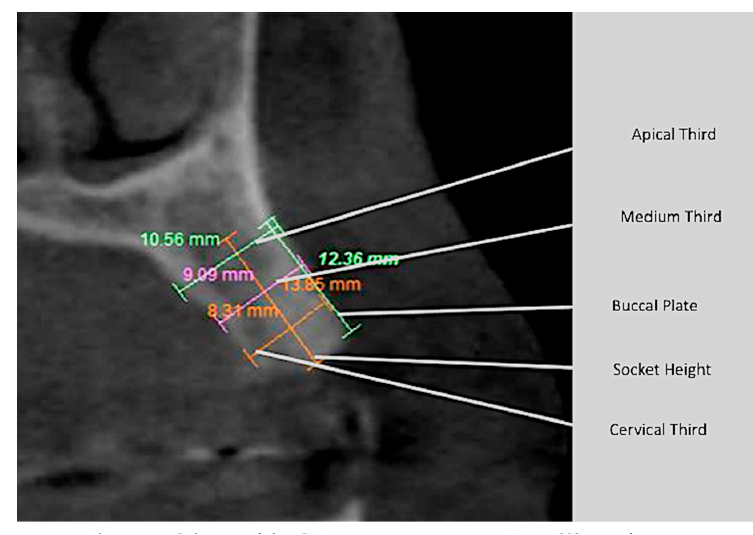
Figure 14. Scheme of the CT measurements, using DentalSlice software.